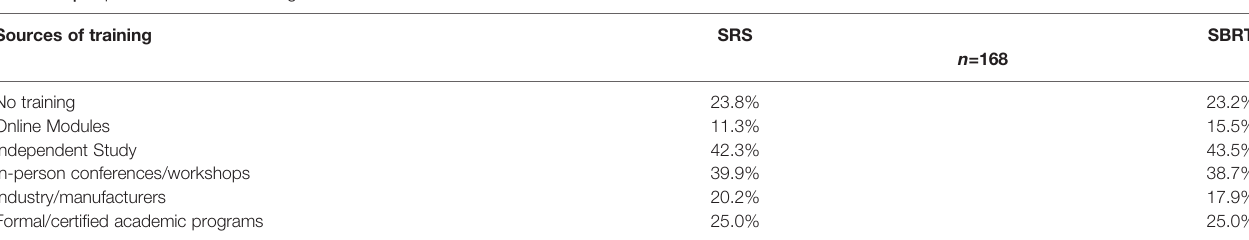
TABLE 1 | Reported sources of